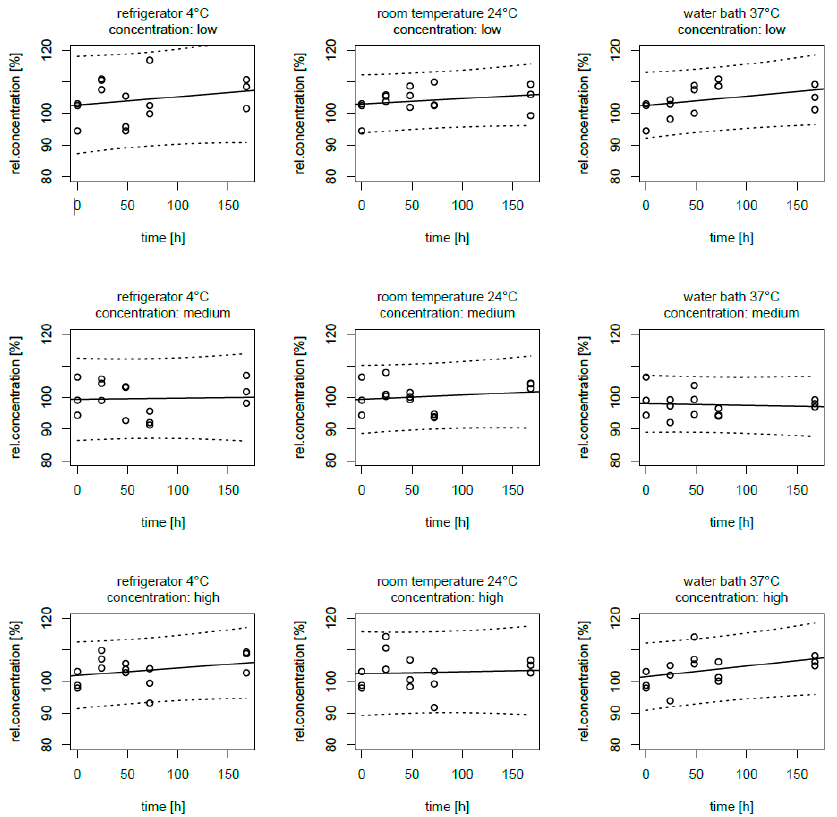
Figure 1. Relative voriconazole concentrations over one week (168 h) in SMK AiO PN admixtures, results of the LC–MS/MS analysis; linear fitting with prediction intervals at the specified level of 95%.